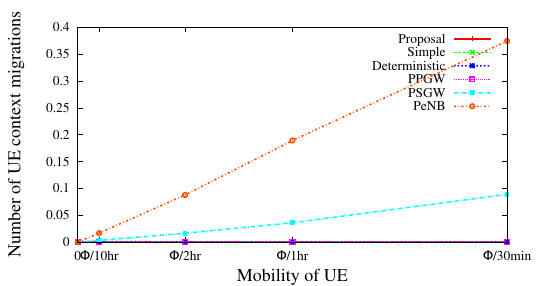
Figure 9: Fairness in Scenario 1 ( ρ = 0 )